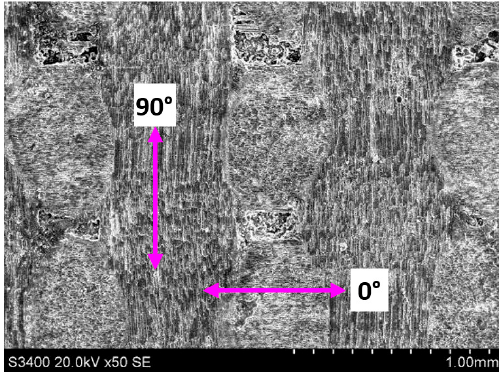
Figure 7. Typical C/SiC grinding surface